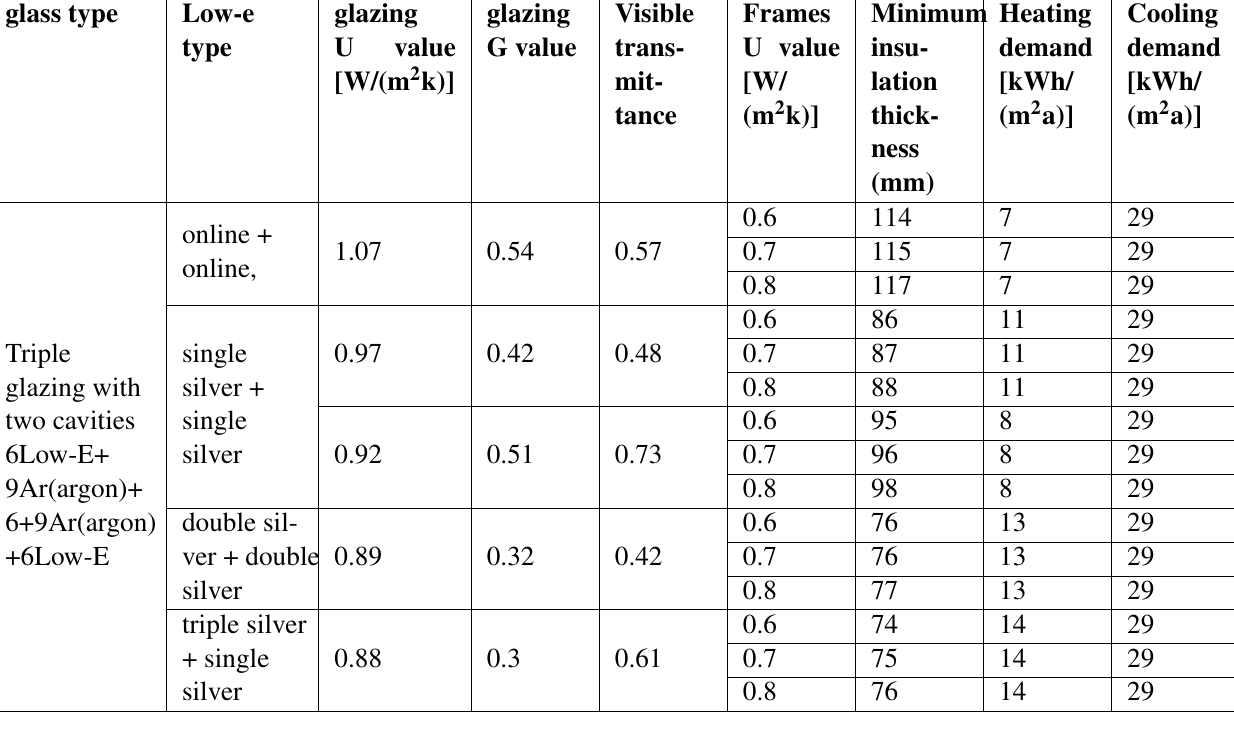
Table 4 Different glass materials and minimum insulation